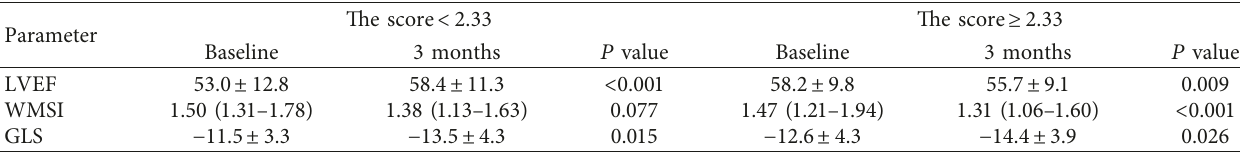
Table 6: Baseline and 3-month echocardiographic parameters according to the optimal cutoff value for the predictive model. The score < Parameter